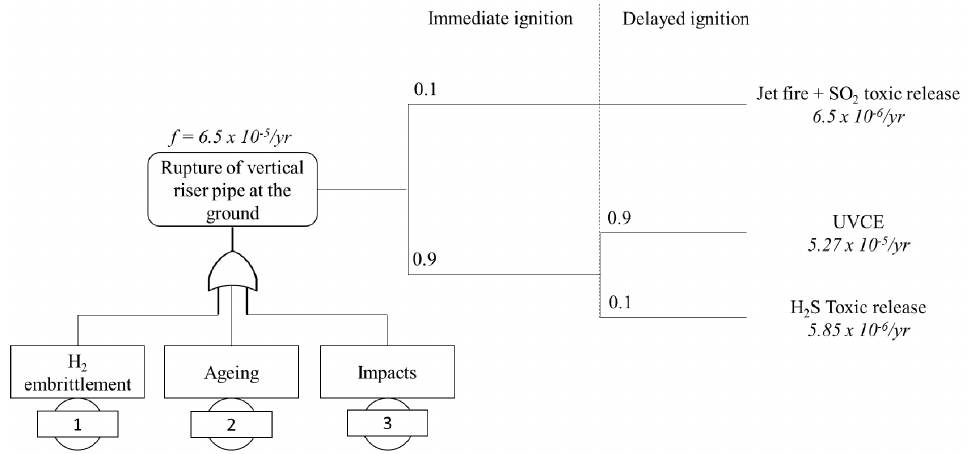
Figure 2. Bow-tie diagram with “Rupture of vertical riser pipe at the ground” as initiating event/top event.